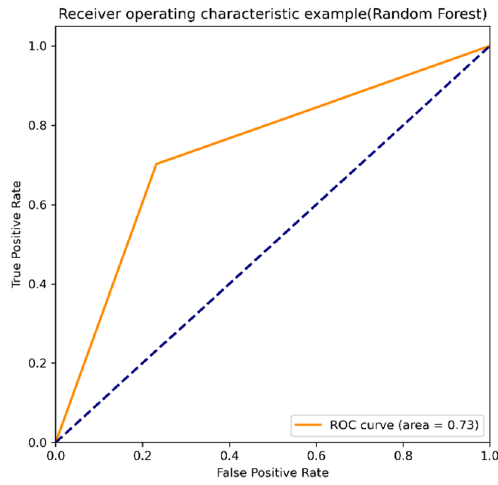
Figure 2. ROC in Nantung direction. Figure 4. ROC in Nantung direction. Figure 4. ROC in Nantung direction.